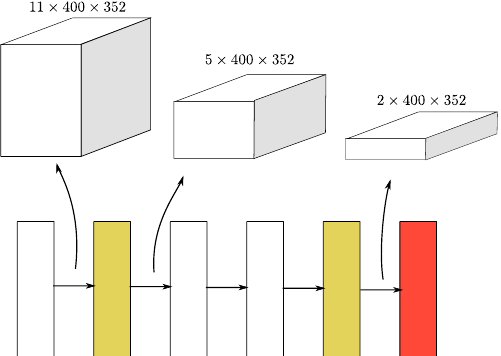
Figure 3. The structure of our proposed sparse middle feature extractor. The yellow boxes represent sparse convolution, the white boxes represent submanifold convolution, and the red box represents the sparse-to-dense layer. The upper part of the figure shows the spatial dimensions of the sparse